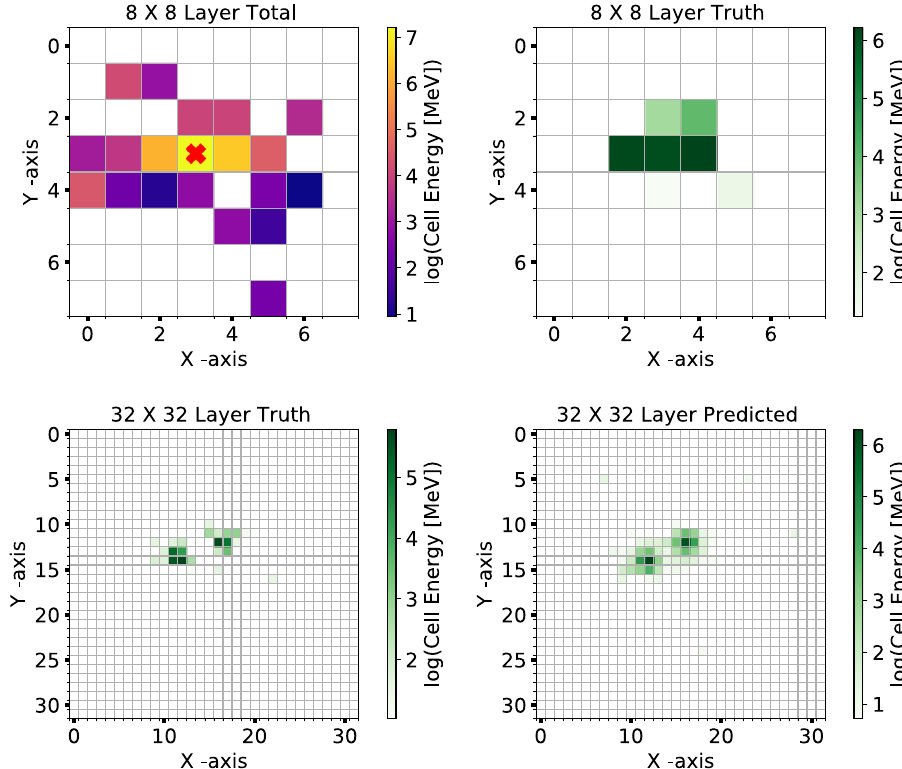
Fig. 7 An event display of total energy shower (within topocluster), as captured by a calorimeter layer of 8 × 8 granularity, along with the location of the track, denoted by a red cross (left) and the same shower is captured by a calorimeter layer of 32 × 32 granularity (middle). The bottom right panel shows the corresponding event predicted by the NN. The figure shows that the shower originating from a π 0 → γγ is resolved by a 32 × 32 granularity